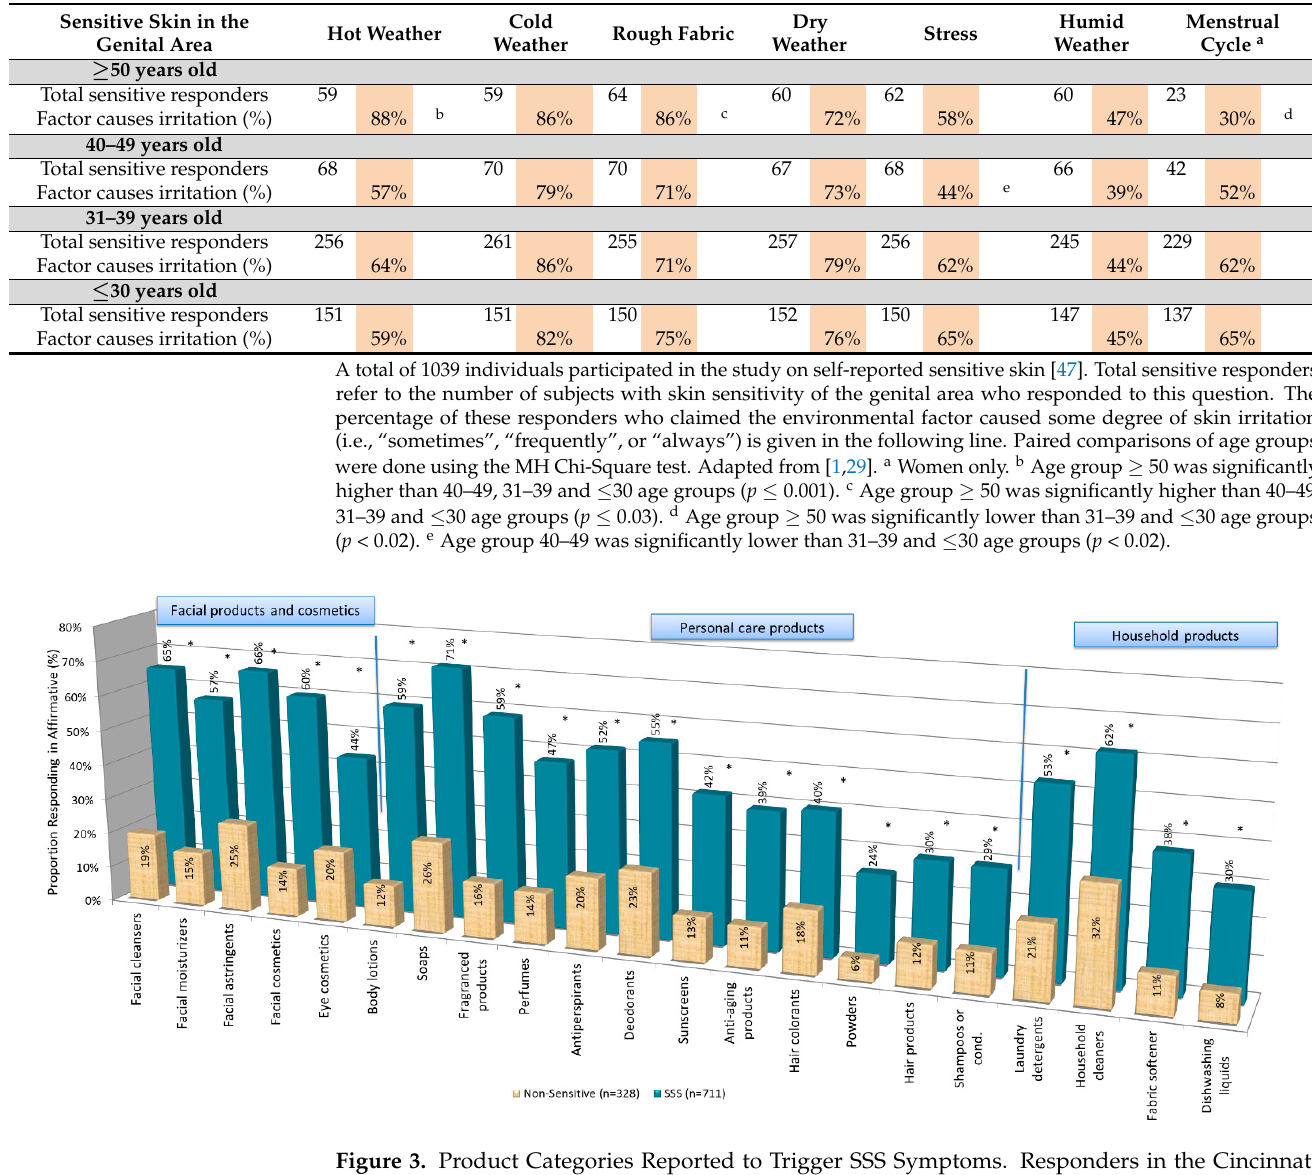
Figure 4. SSS Consumers and Shopping Practices. In the Cincinnati study, responders were asked about specific shopping practices. Compared to the non-SS group, the SS subjects were far more likely to: ( a ) look for skin related claims on products (such as, “safe for sensitive skin” and “hypo- allergenic”) (OR = 5.3), and ( b ) avoid specific ingredients when shopping (OR = 5.2). Consumer product manufacturers are now fully aware of the need to develop prod- ucts specifically for individuals with SSS. Our laboratory developed and validated a self- administered scientific tool, (the Farage Quality of Life [FQoL™]), to assess the potential impact of a variety of consumer products on Health Related QoL (HRQoL) [50,51]. The tool consists of 27 general items scored on a Likert scale and covering Overall Quality of Life (1 item), Well-Being (12 items), and Energy and Vitality (14 items). The Well-Being domain has 3 subscales: Emotion, Self-Image, and Self-Competence; the Energy and Vi- tality domain also has 3 subscales: Personal Pleasure, Physical State, and Routine Activity. The resulting FQoL™ instrument has been used several times to evaluate the impact of various consumer products on the consumers’ quality of life [52].